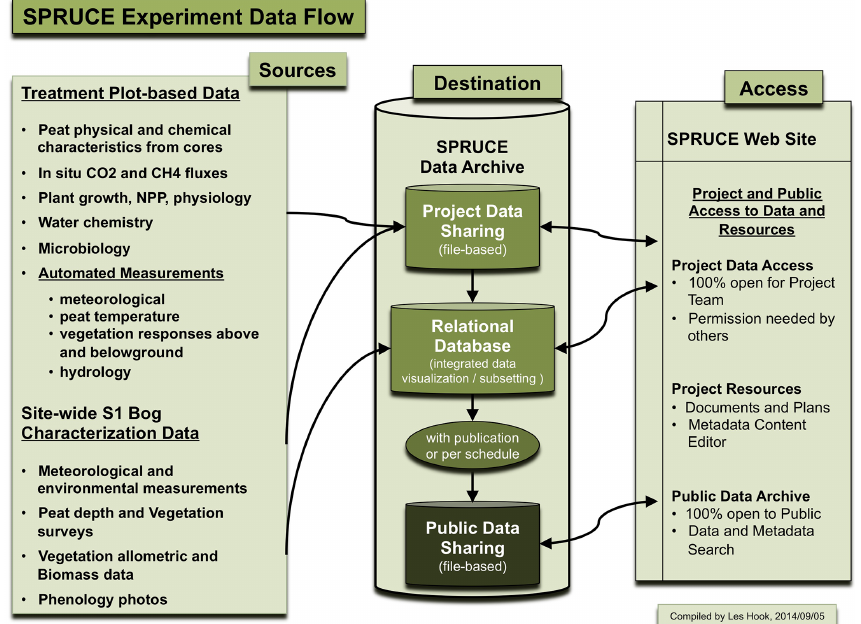
Figure 7. The data flow